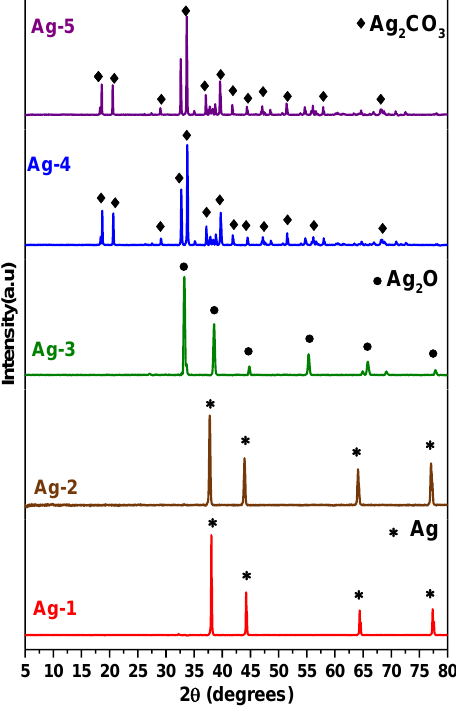
Figure 1. XRD patterns of synthesized Ag-containing nanomaterials. The average crystal sizes of the Ag metal phase in Ag-1 and Ag-2 samples are 19.8 nm and 19.9 nm, respectively, as per the crystallite size calculated by the Scherrer equation (Equation (1)).